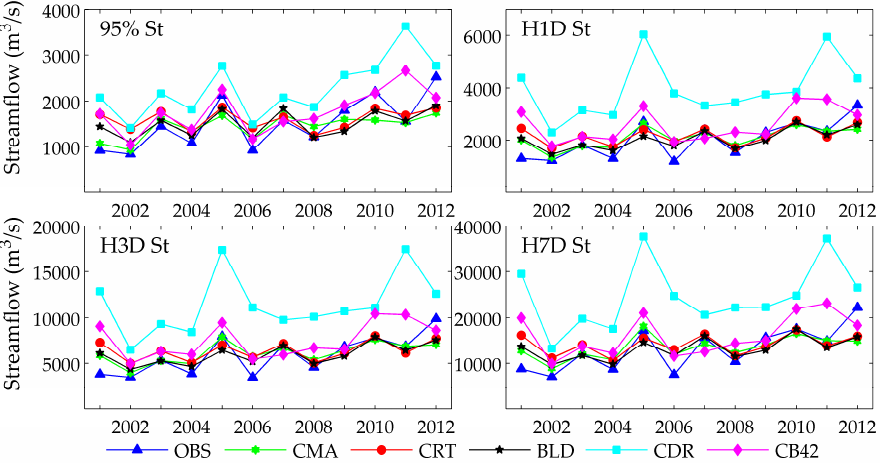
Figure 8. The extreme values of observed streamflow and simulated streamflow forced by four SGPEs from 2001 to 2012.